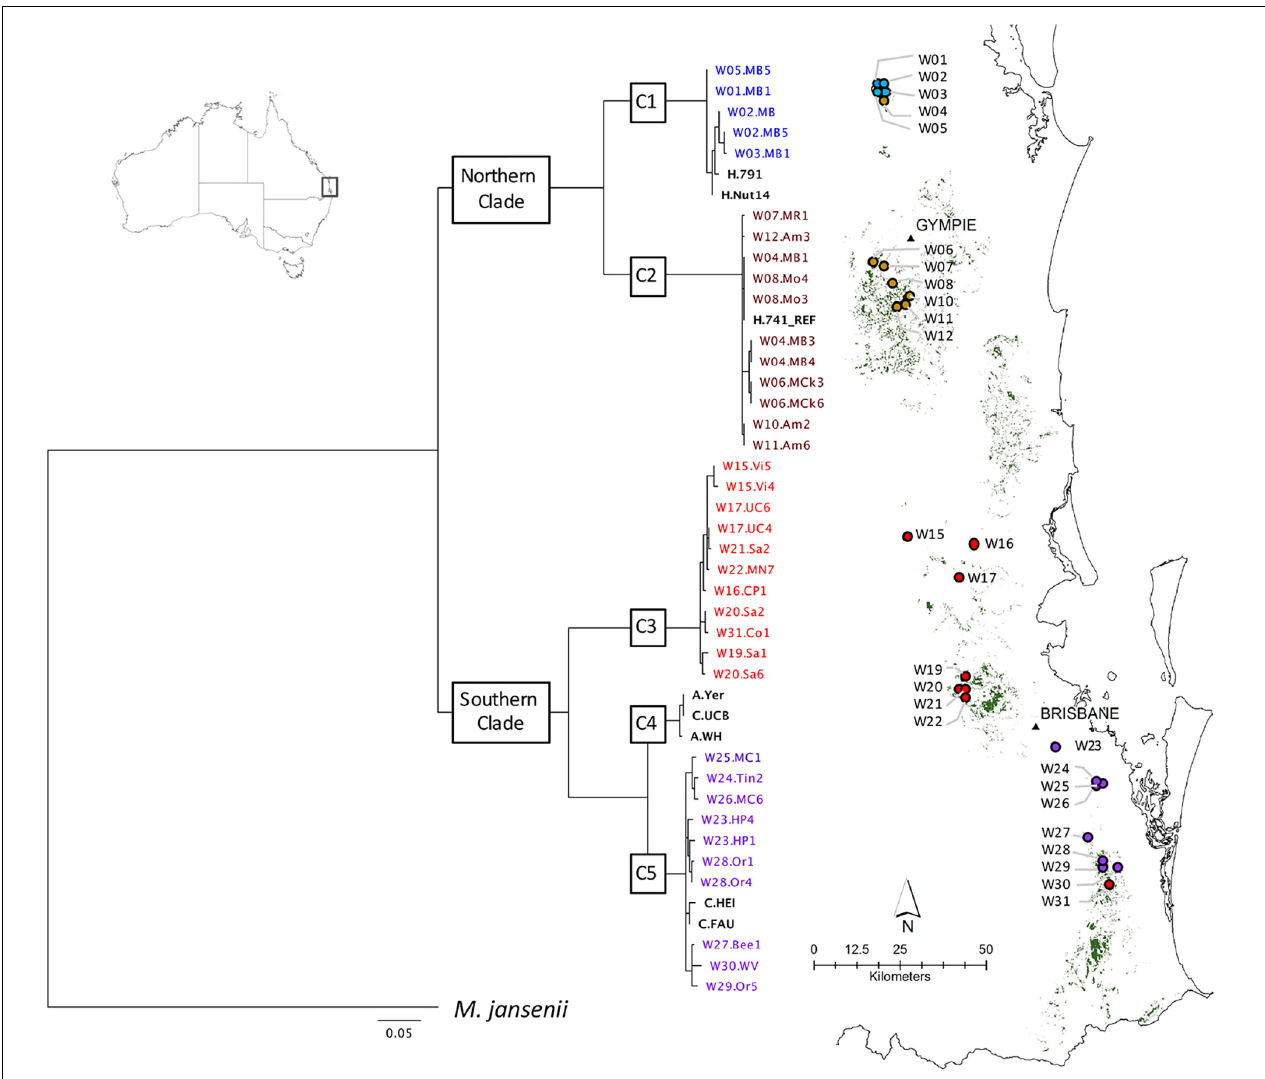
FIGURE 1 | Geographic distribution of wild accessions relative to predicted remnant distribution (in green). Maximum likelihood phylogenetic tree (-lnL –32222.8) on left was inferred using RAxML from a 506 bp chloroplast SNP alignment of chloroplast haplotypes of 63 Macadamia integrifolia wild and domesticated accessions. The chlorotype of the reference genome (H.741_REF) was identical to those of three wild accessions (W08.Mo3, W08.Mo4, W04.MB1) and 18 other Hawaiian cultivated accessions. Bootstrap support for the two major clades and five sub-clades (C1–C5) was 100%. The outgroup was M. jansenii . Scale is substitutions per site. Cultivated accessions are in bold black and colors are used for the wild accessions and sites to identify the sub-clades to which they